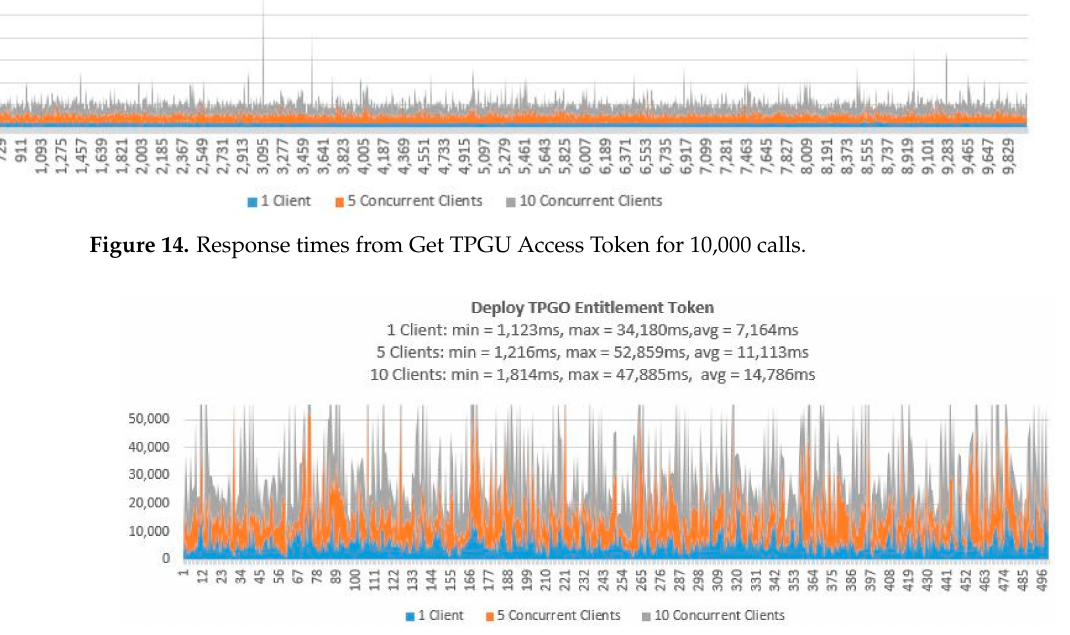
Figure 15. Response times from Deploy TPGO Entitlement Token for 500